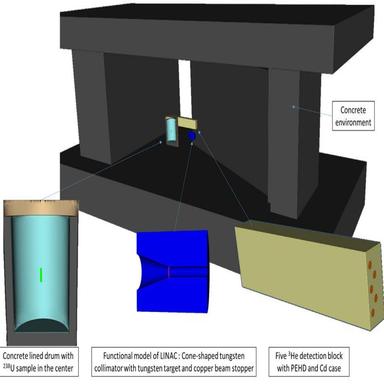
3D view of the MCNP6 simulation model.